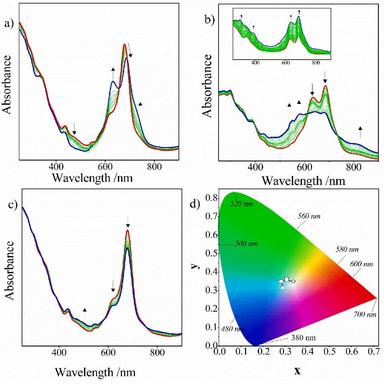
In-situ UV–Vis spectral changes of (1.0 × 10− 4 mol dm− 3 ) LuPc2 in CH2CL2/TBAP electrolyte. a) Eapp = 0.00 V. b) Eapp = − 1.50 V. c) Eapp = 1.20 V. d) Chromaticity diagram (each symbol represents the electro-generated color of the species; □: ; ○: 1− ; Δ: 3− ; ☆: 2+.